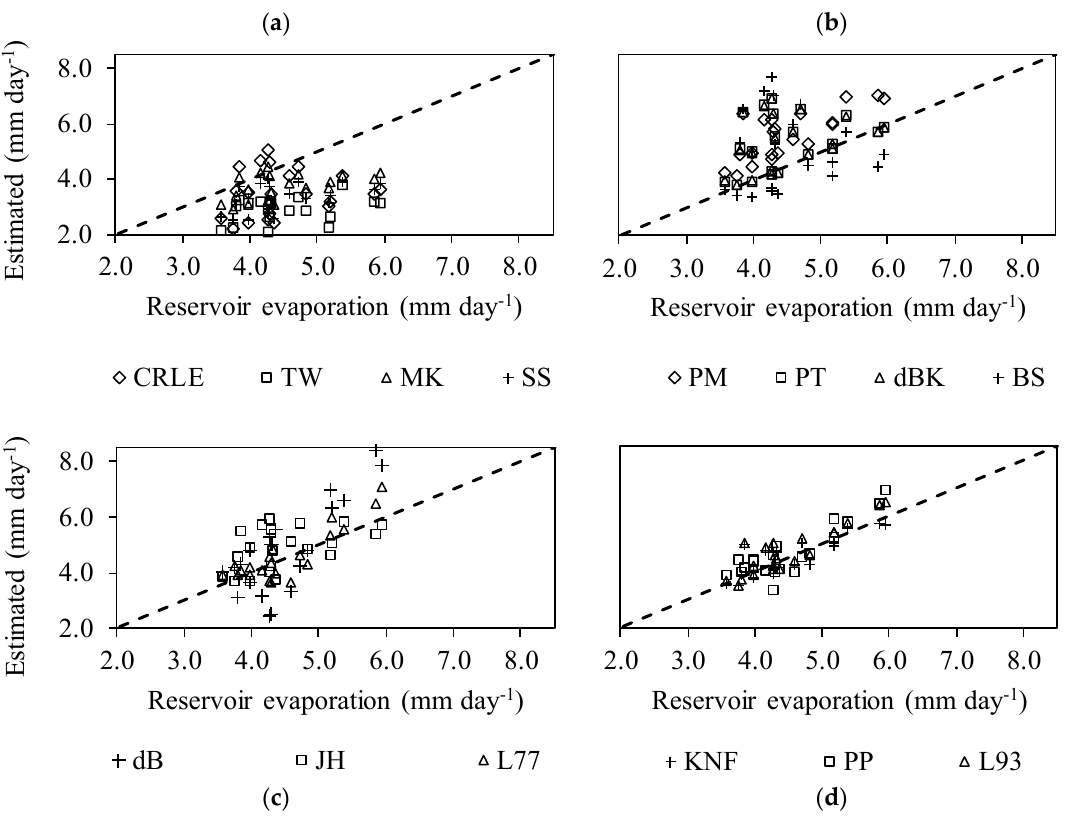
Figure 5. Relationship between estimated and observed reservoir evaporation. SS = Stephens and Stewart (1963); MK = Makkink (McGuinness et al. 1972); PP = Papadakis (1965); TW = Thornthwaite (1948); PT = Priestley and Taylor (1972); dB = DeBruin (1978); JH = Jensen and Haise (1963); PM = Penman (1948); BS = Brutsaert and Stricker (1979); dBK = DeBruin and Keijman (1979); CRLE = Morton (1983); L77 = Linacre (1977); L93 = Linacre (1993); KNF = Kohler et al. (1955).